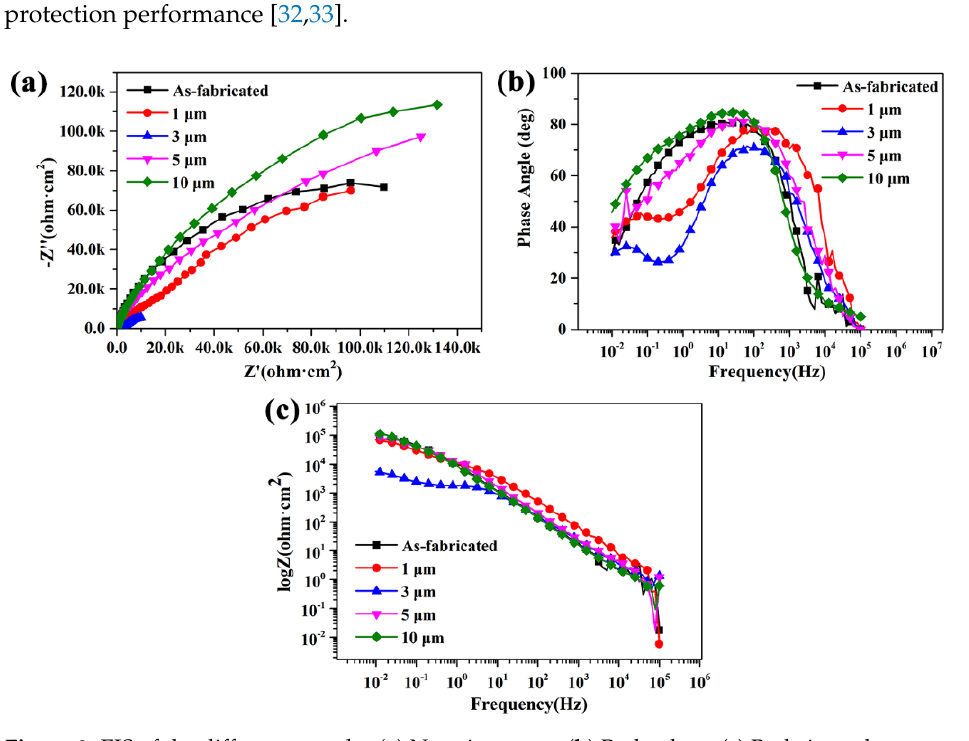
. Figure 10. Equivalent circuit used to fit the data.